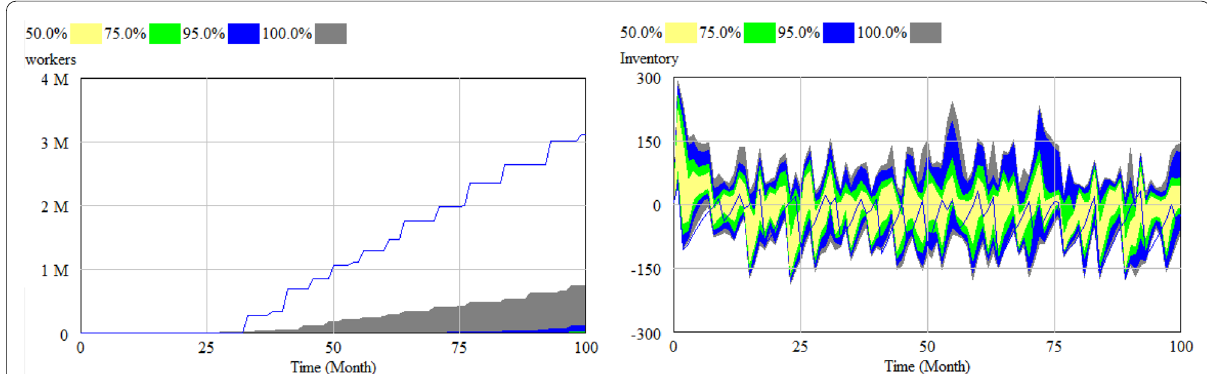
Fig. 9 Sensitivity analysis of the number of “workers” and